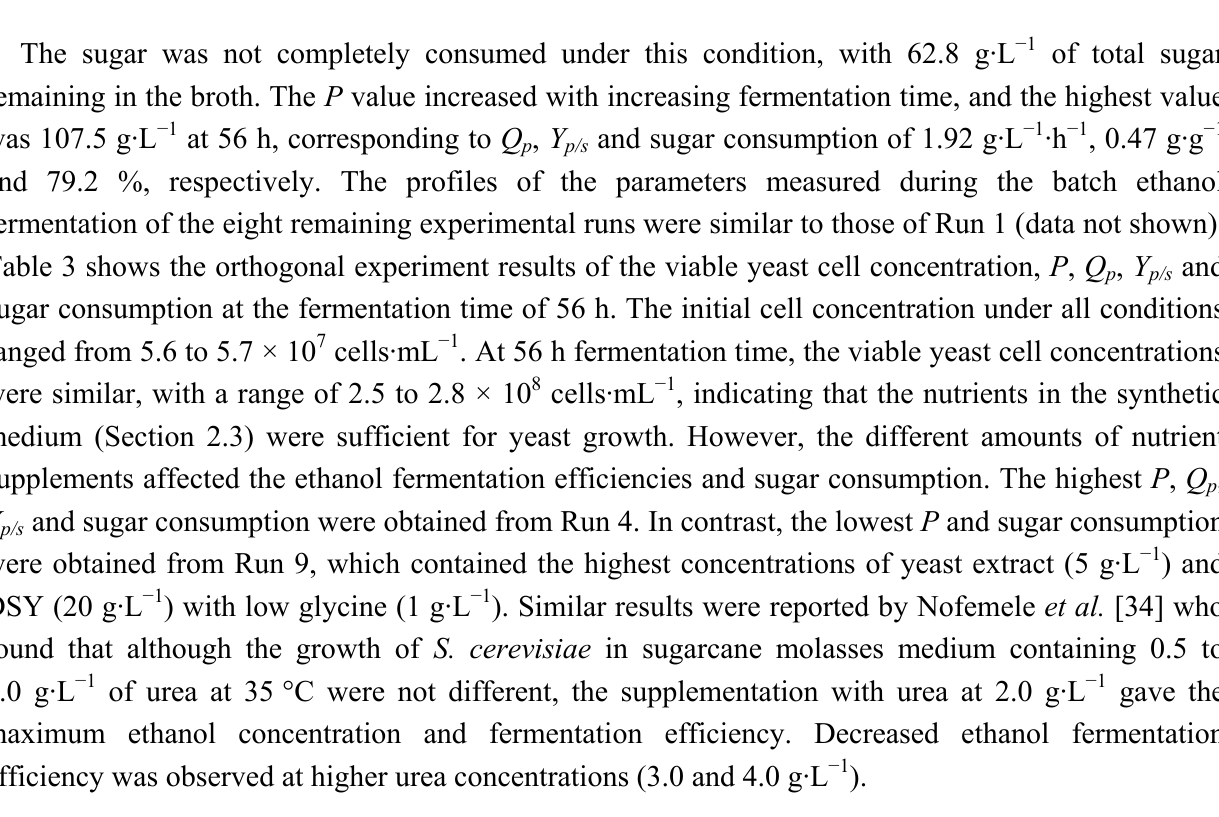
Table 3. Orthogonal experiment results of ethanol fermentation from the synthetic medium containing 280 g·L − 1 of total sugar at the fermentation time of 56